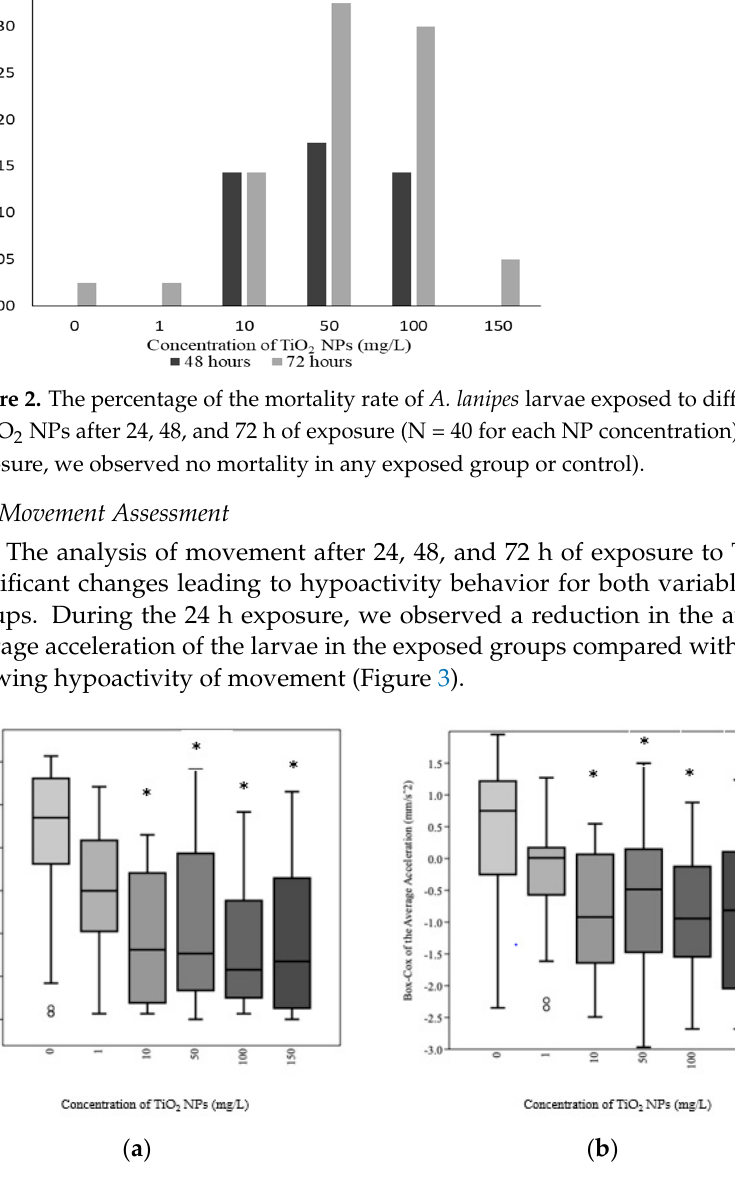
Figure 3. Larvae movement behavior assessment (N = 25 for each concentration). ( a ) Average speed (mm/s) and ( b ) average acceleration (mm/s 2 ) of A. lanipes larvae exposed to different concentrations of TiO 2 NPs in an acute exposure of 24 h (* p < 0.01).